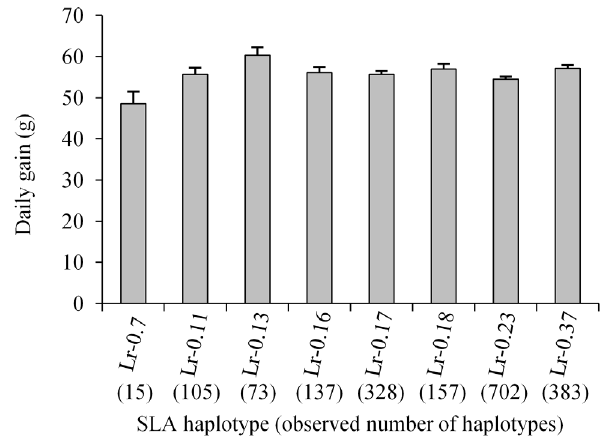
Figure 4. Effect of swine leukocyte antigen (SLA) class II haplotypes on daily gains between the day of birth and 50 days of age in Microminipigs. Columns and bars indicate means and standard error, respectively. The number of haplotypes was counted as two in homozygous individuals. The data from Lr-0.7 were excluded from calculations due to the small number of piglets with this haplotype. No significant difference was observed in daily gains between the